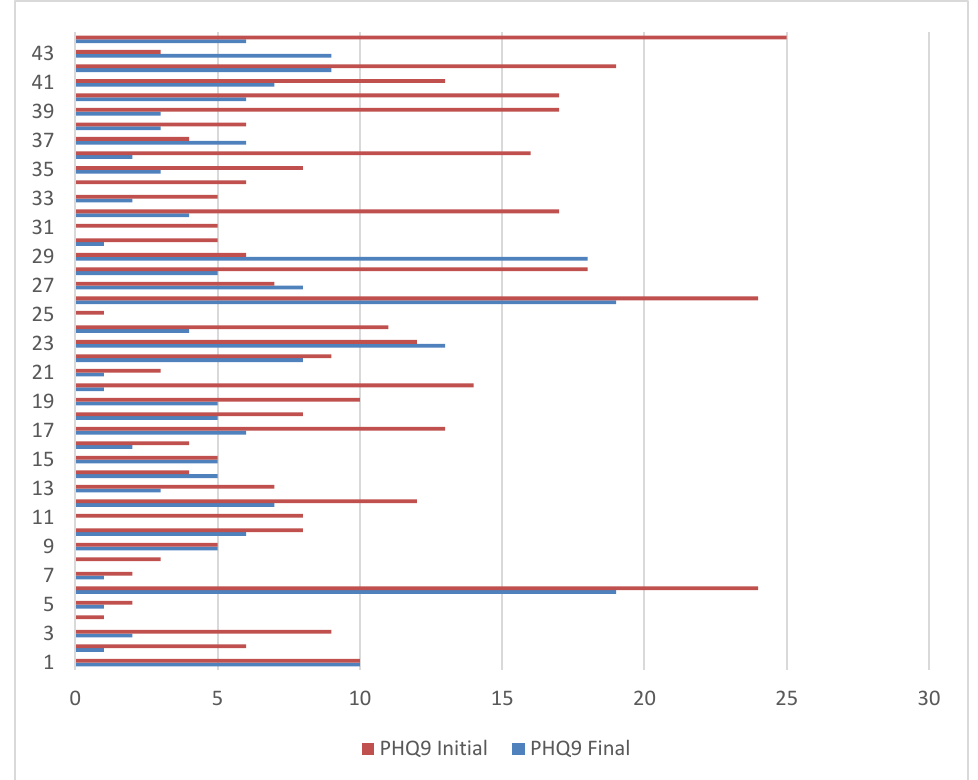
Figure 1. Initial and final PHQ–9 ( n = 44).